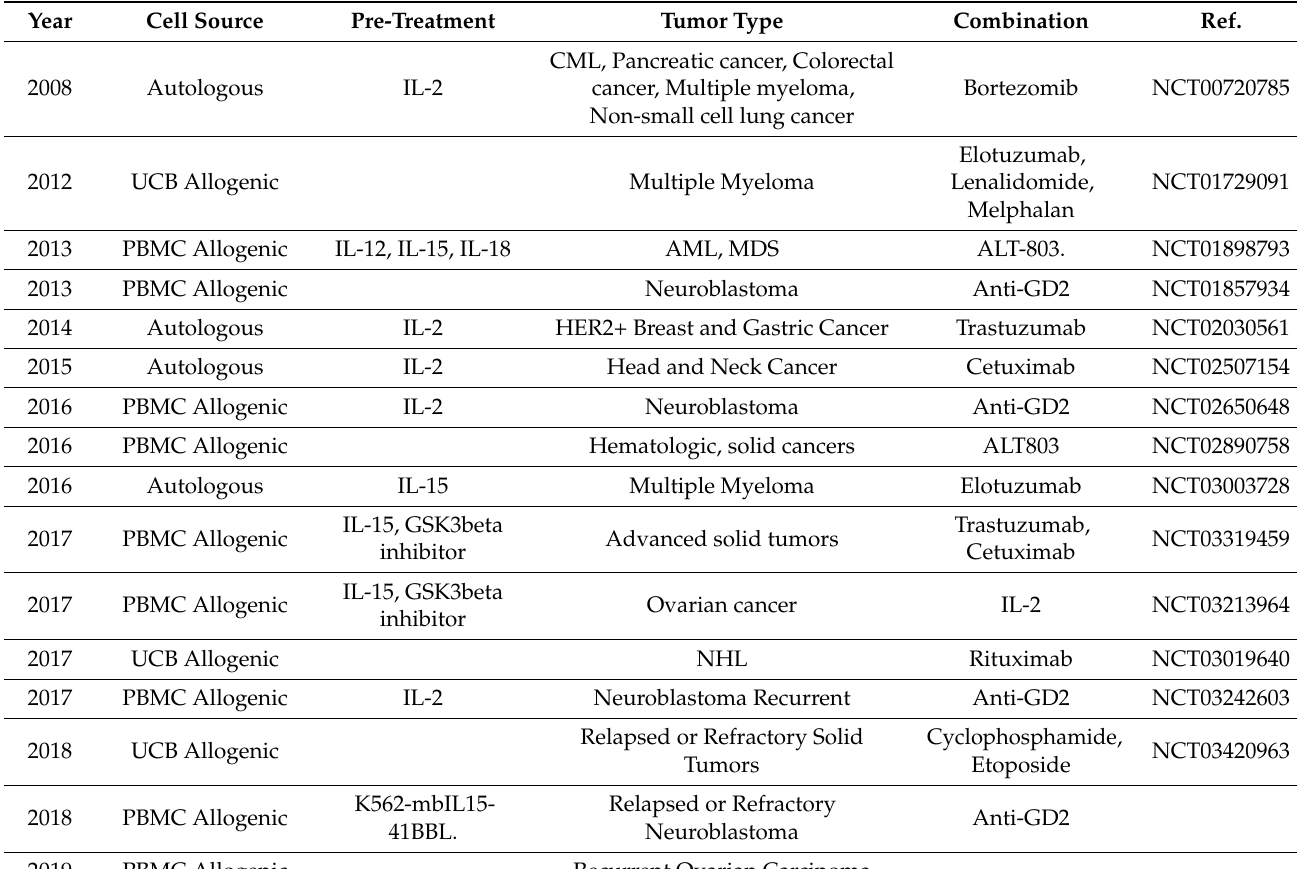
Table 1. Selected recent ongoing NK cell-based combination clinical